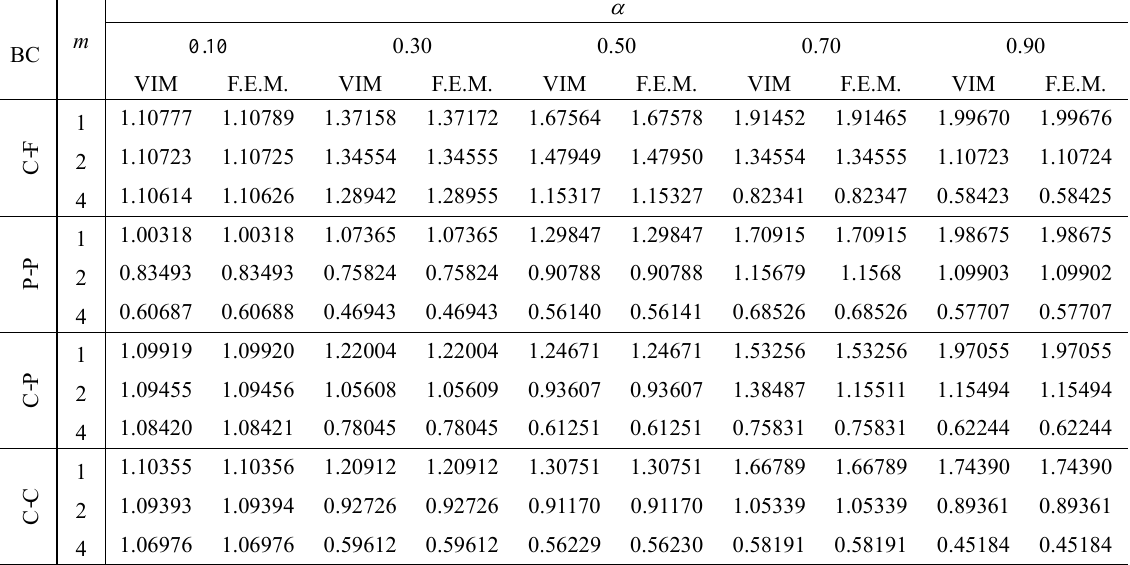
( n =2.0) with VIM results 1